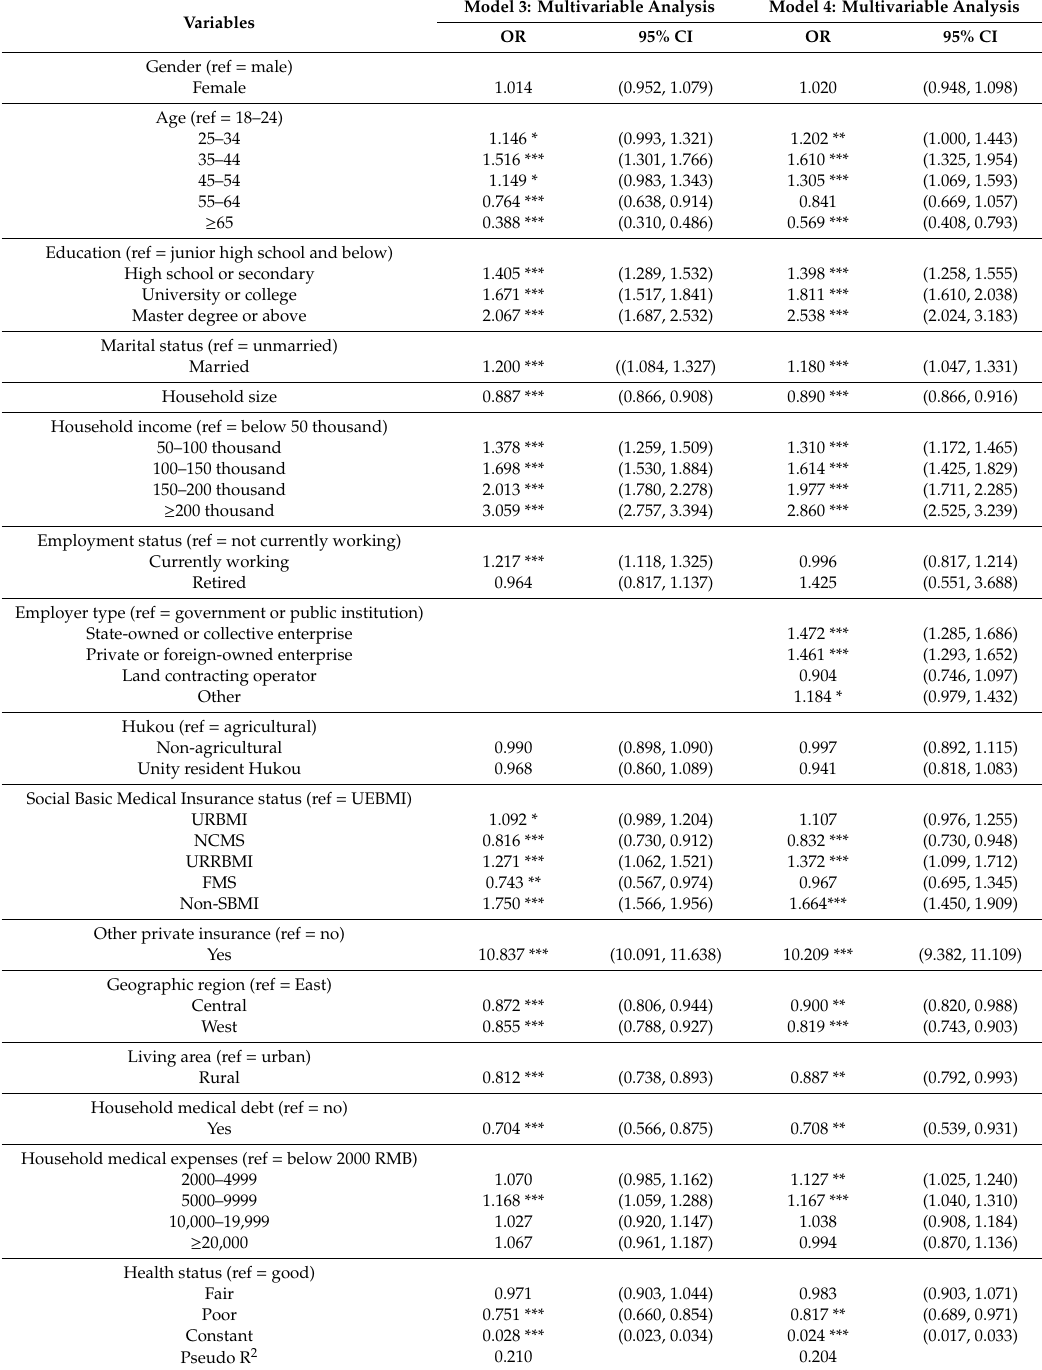
Table A1. Binary logistic regression analysis of predictors of PHI